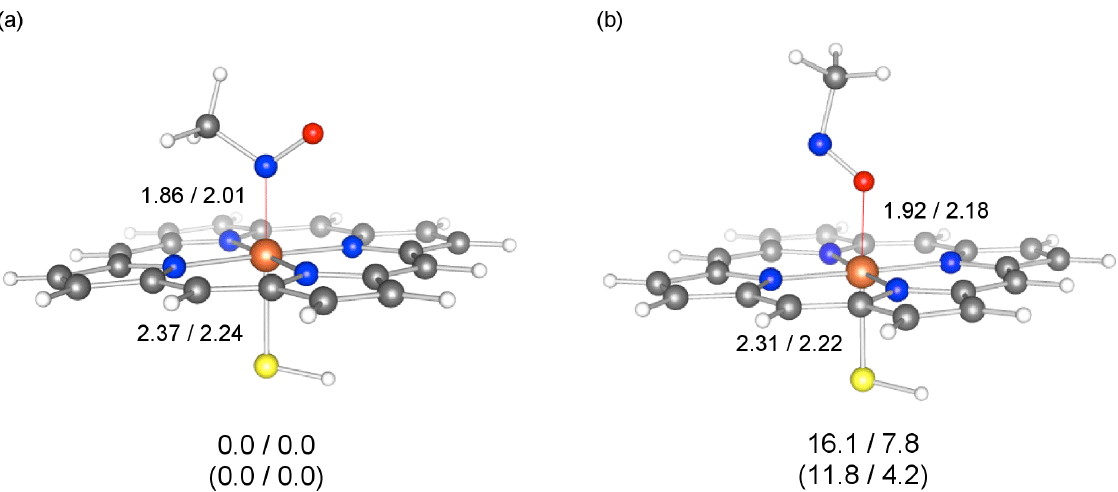
Figure 3. M06/B1-optimized geometries of 1 MIC(II) and 2 MIC(III): ( a ) the N-bound form and ( b ) the O-bound form. Key distances are given in Å. The values below the geometries are relative energies (kcal/mol) obtained at the M06(SCRF)/B2 level ( 1 MIC(II)/ 2 MIC(III)), while the values in parentheses are relative energies obtained at the B3LYP(SCRF)/B2